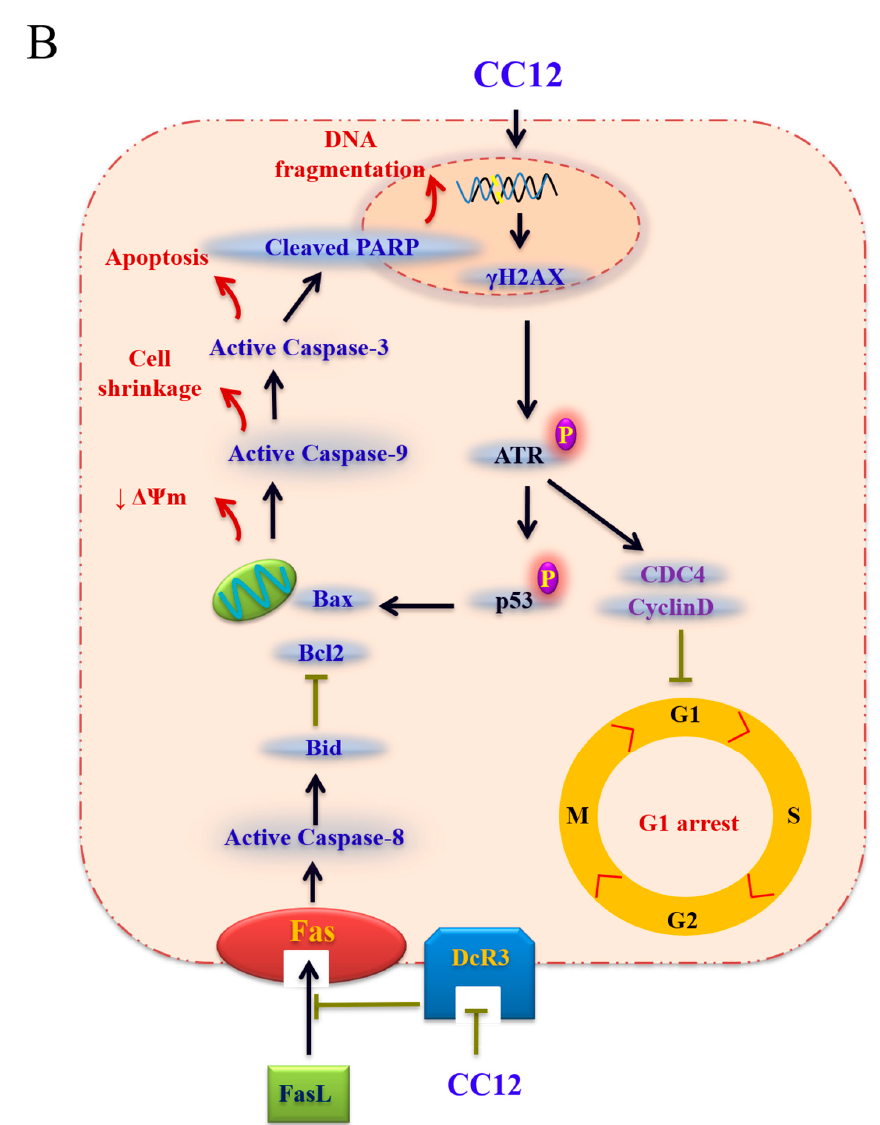
Figure 5. CC12 affected the expression of the proteins of intrinsic and extrinsic apoptotic pathways, and tumor prognostic marker Decoy receptor 3 (DcR3). ( A ) Western blot. ( B ) The possible mechanism.